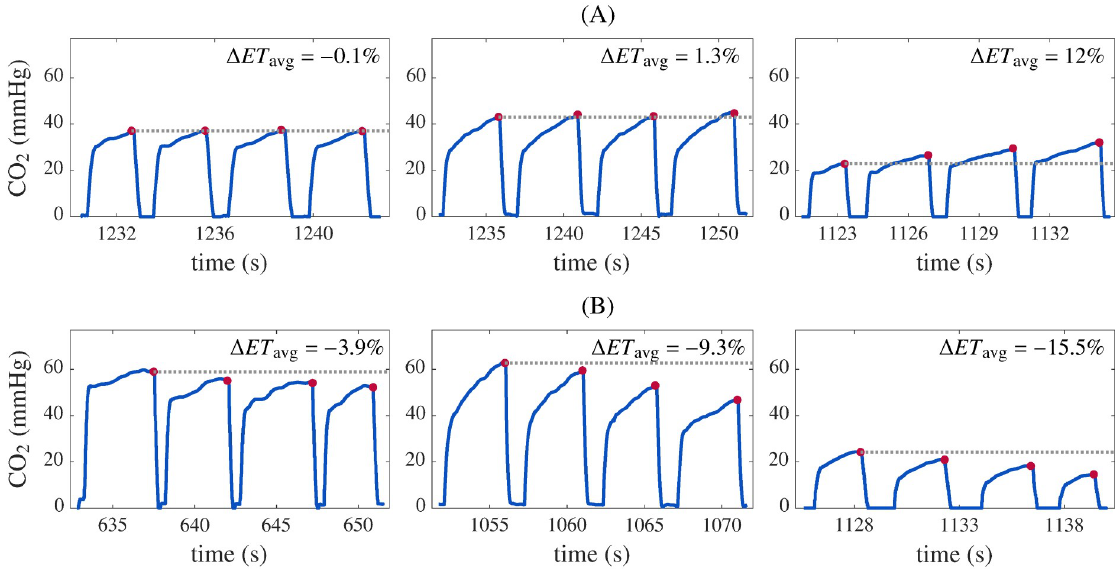
Fig 3. Illustration of the behavior of Δ ET avg . ROSC (A) and non-ROSC (B) capnogram segments with different Δ ET avg values.